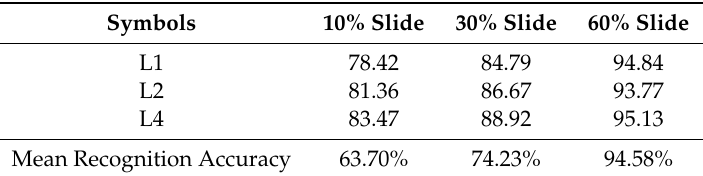
Table 13. SMotion dataset results for di ff erent sliding